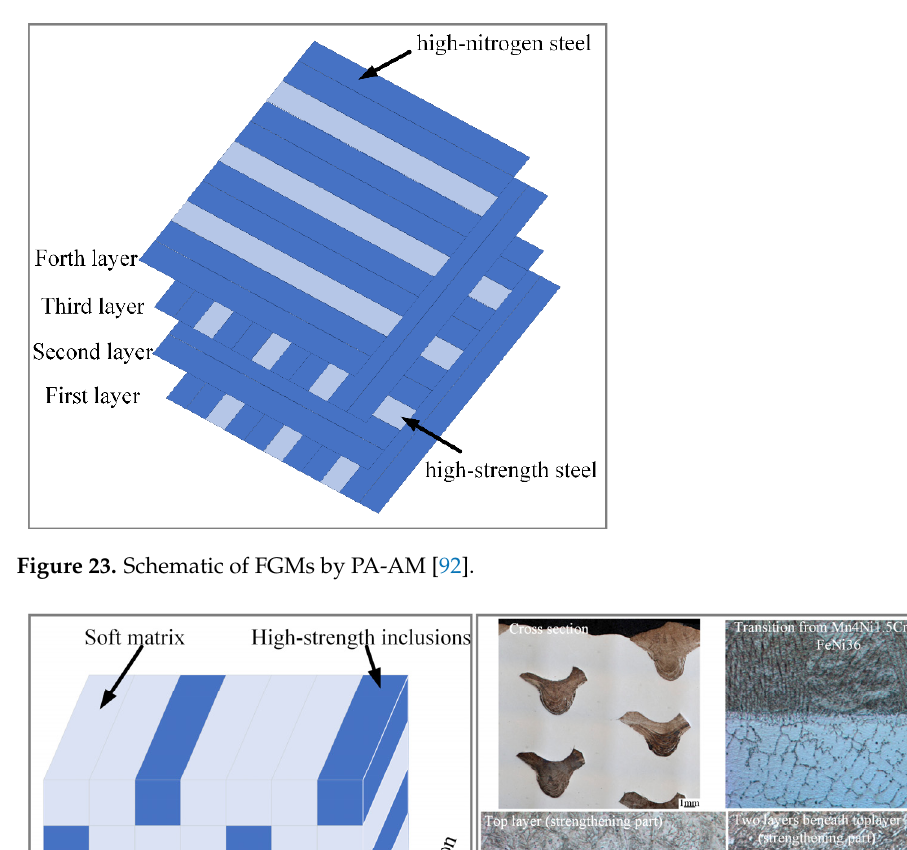
Figure 22. ( a ) Schematic of WAAM based on CMT with heterogeneous wires, ( b ) Schematic of FGMs [90].